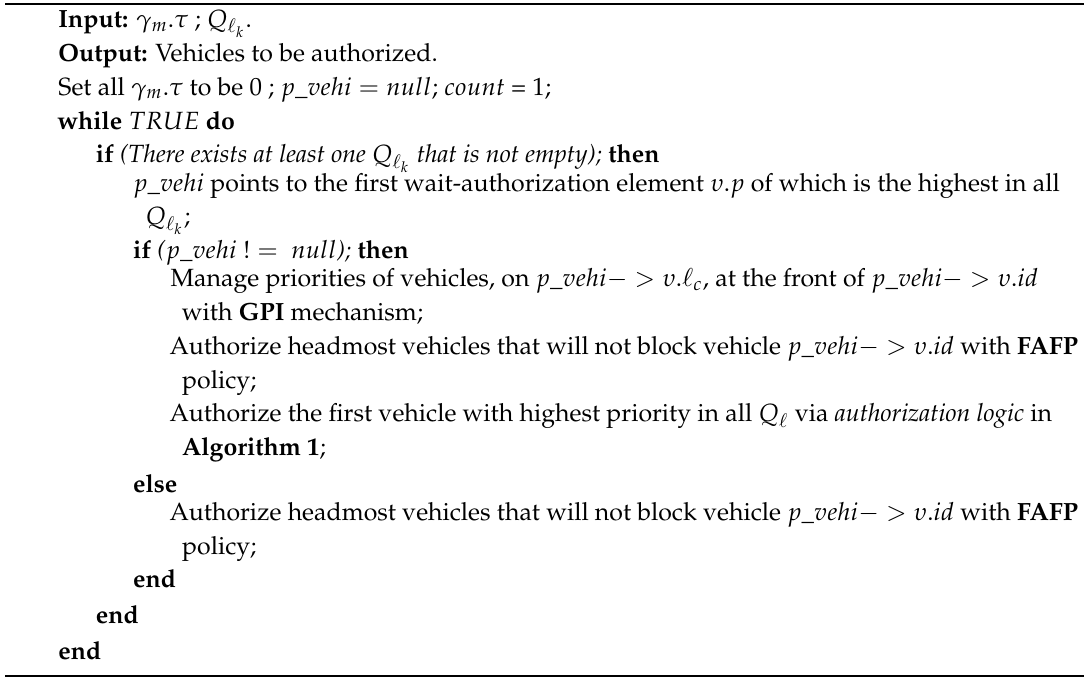
ALGORITHM 2: GPI-based Authorization Mechanism with HQEP